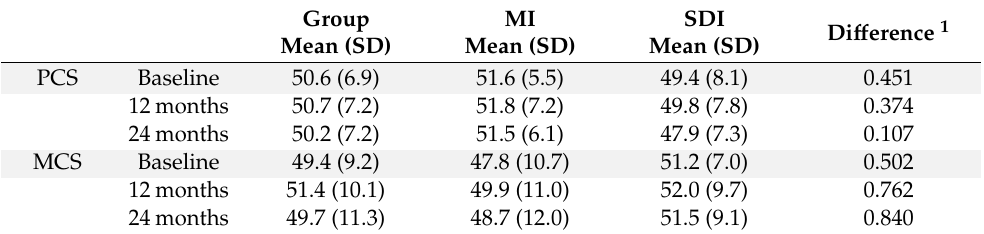
Table 4. Short Form-36 (SF-36) summary scores across the three time points according to intervention type (ITT analysis) ( n =